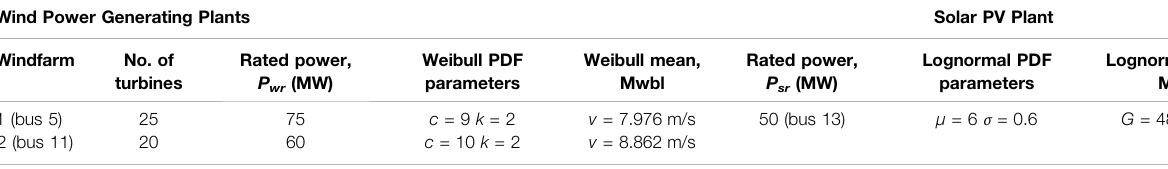
TABLE 10 | PDF parameters of wind power and solar PV plants. Wind Power Generating Plants